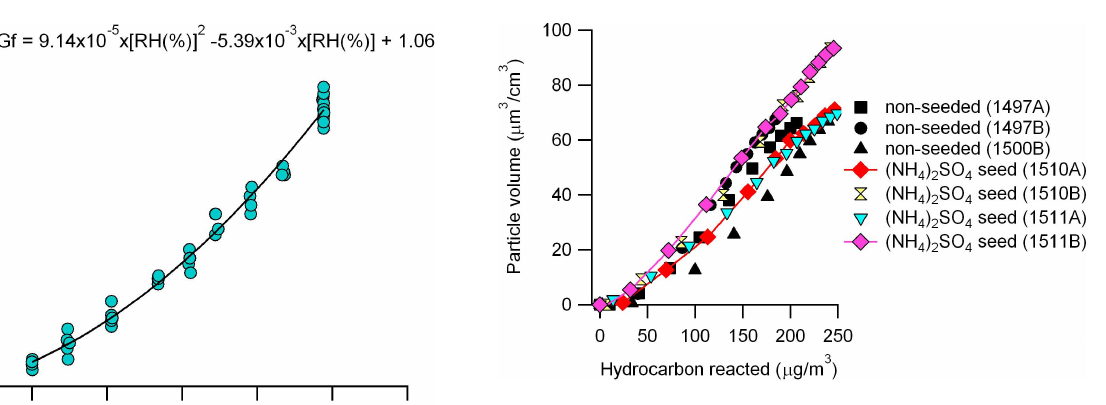
Fig. 8. SOA growth curves (particle volume vs. toluene reacted) of non-seeded experiments and deliquesced ammonium sulfate seed experiments. No significant difference in particle growth between those two systems was observed, indicating that contribution from glyoxal uptake onto deliquesced ammonium sulfate was minor in this